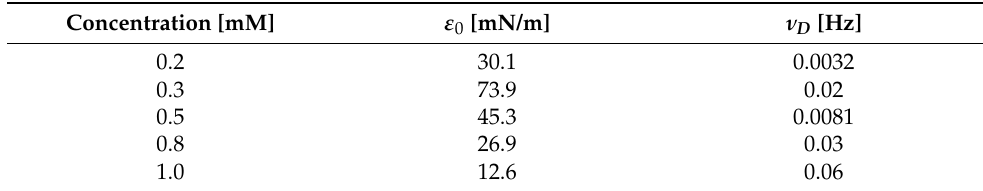
Figure 7. The dependence of the ratio of second to first harmonics in the Fourier spectrum of sur- face tension oscillations on LAE concentration for frequency of 0.01 Hz and 0.1 Hz. Lines were drawn to guide the eye.